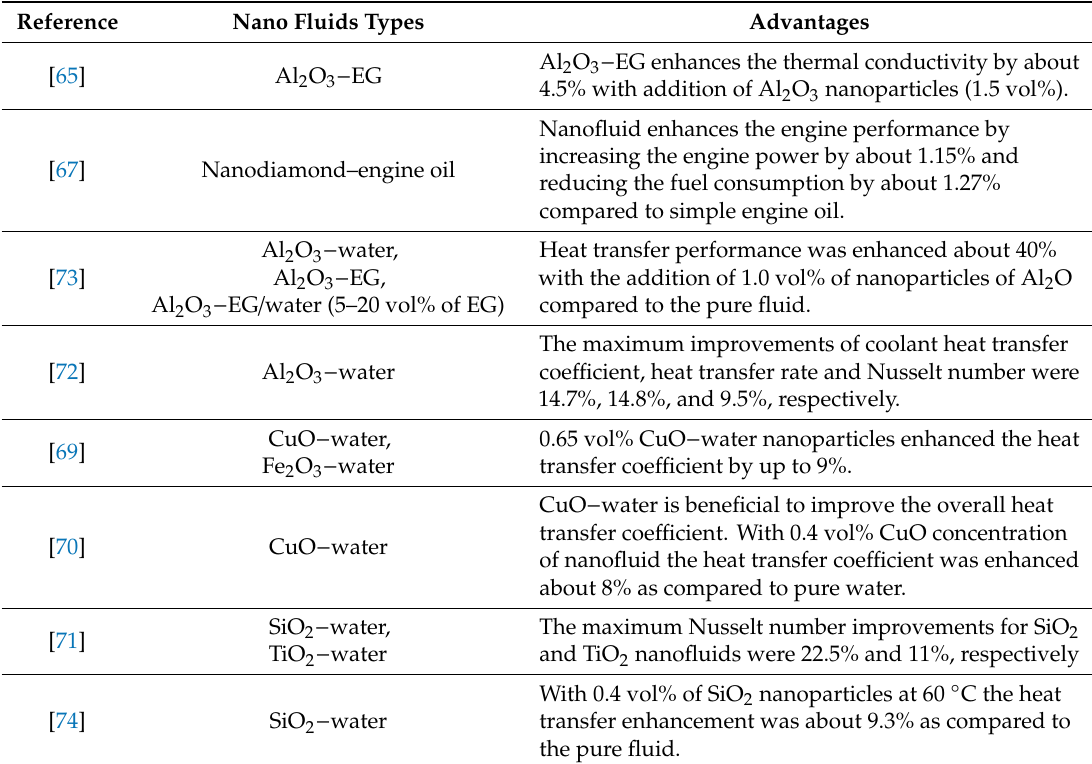
Table 1. Experimental studies of nanofluids for vehicle system cooling.